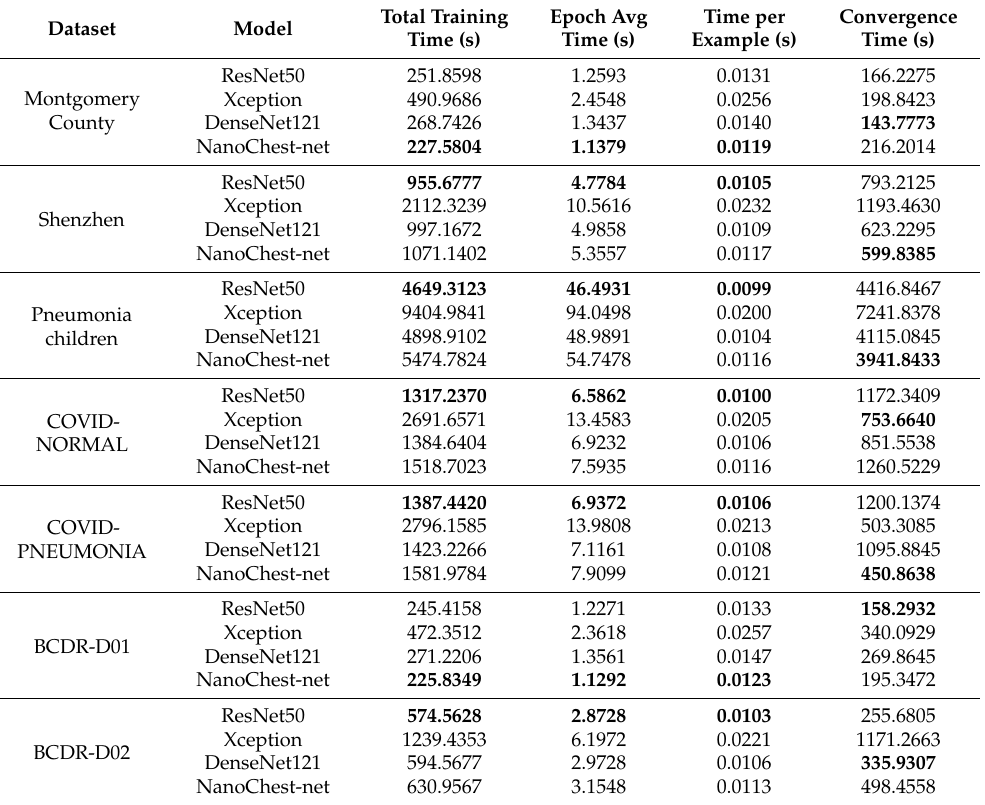
Table 9. Time measurements of CNN models over all